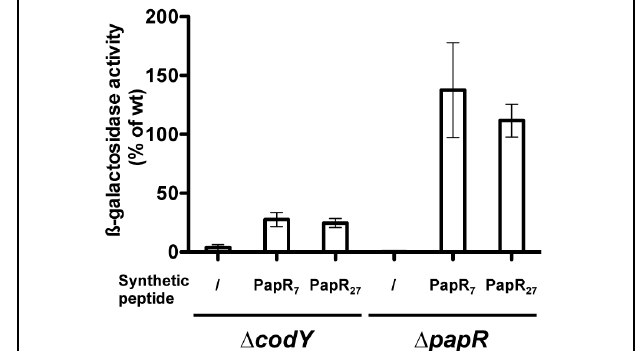
FIGURE 5 | Extracellular complementation assay of (cid:2) papR cells with conditioned medium from (cid:2) codY compared to wild-type cells. The culture supernatant of (cid:2) codY , (cid:2) papR and wild-type cells was filter-sterilized before being used to resuspend (cid:2) papR cell pellets. The latter harbor a chromosomal transcriptional fusion between the promoter of plcA and lacZ . Cells were grown in LB at 37 ◦ C. All samples were collected 0.5 h after entry into stationary phase. β -galactosidase production was assayed after resuming growth for 1.5 h. The results are the mean values of two independent experiments, and the error bars represent standard deviation.